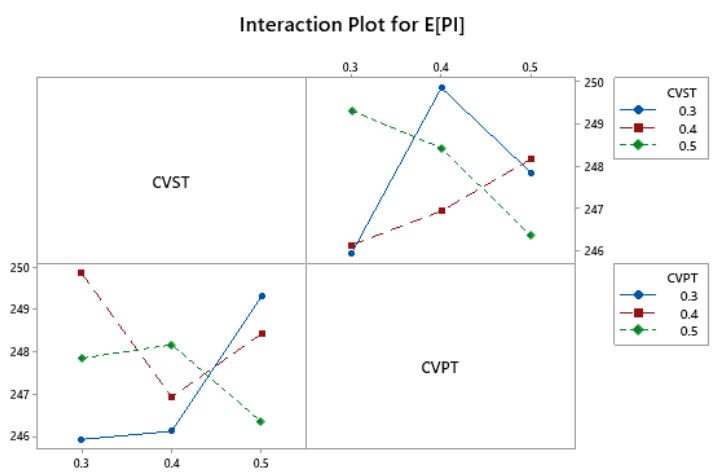
Figure 5. Interaction plots of the CVST-CVPT for E[E/T].